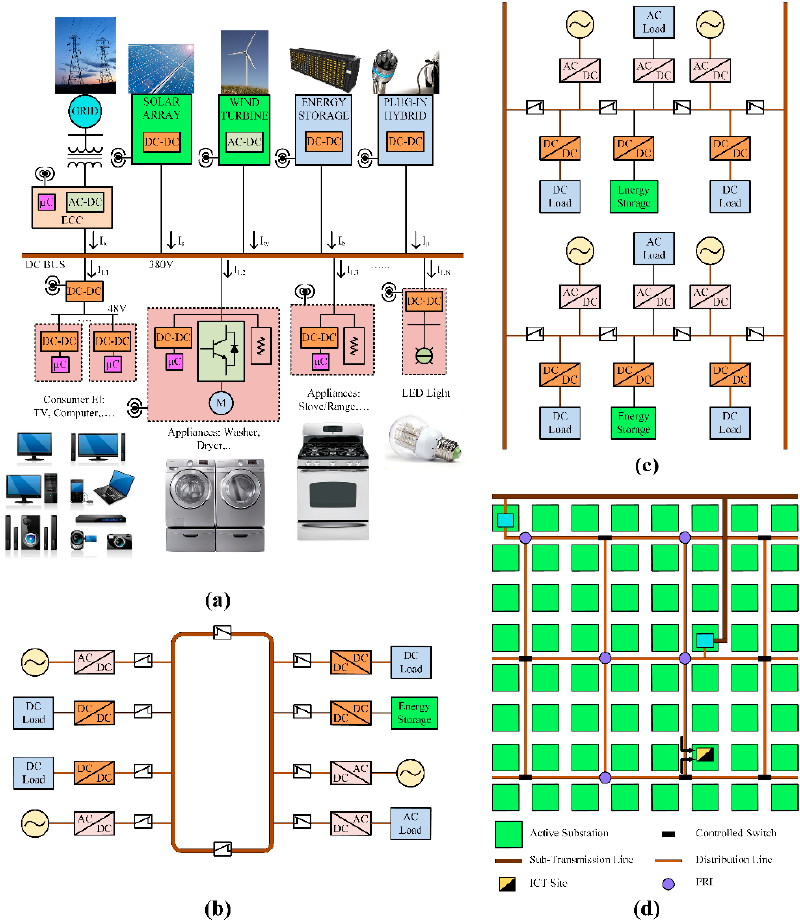
Figure 1. DC bus structures: ( a ) radial; ( b ) ring; ( c ) ladder; ( d ) meshed. Table 1. Advantages and disadvantages of different DC bus structures.